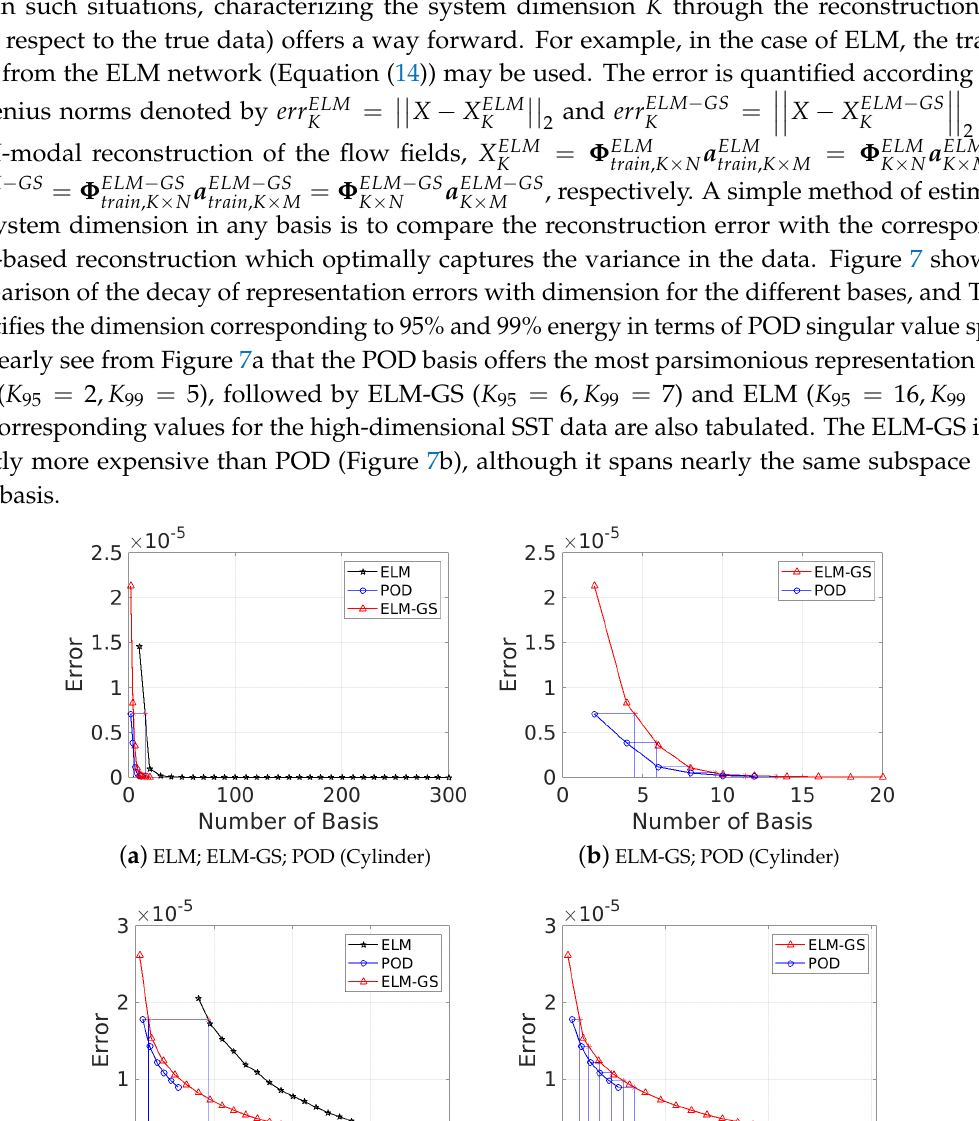
, err ELM , err ELM − GS ) decay using different numbers of bases K K K